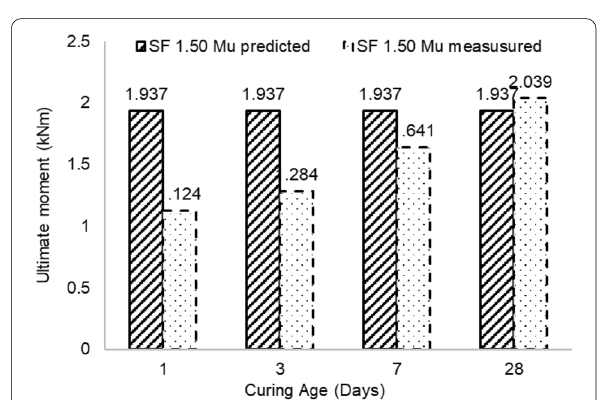
Fig. 9 Comparison between predicted and measured ultimate moment capacity at each measured date-1.50% SFRC